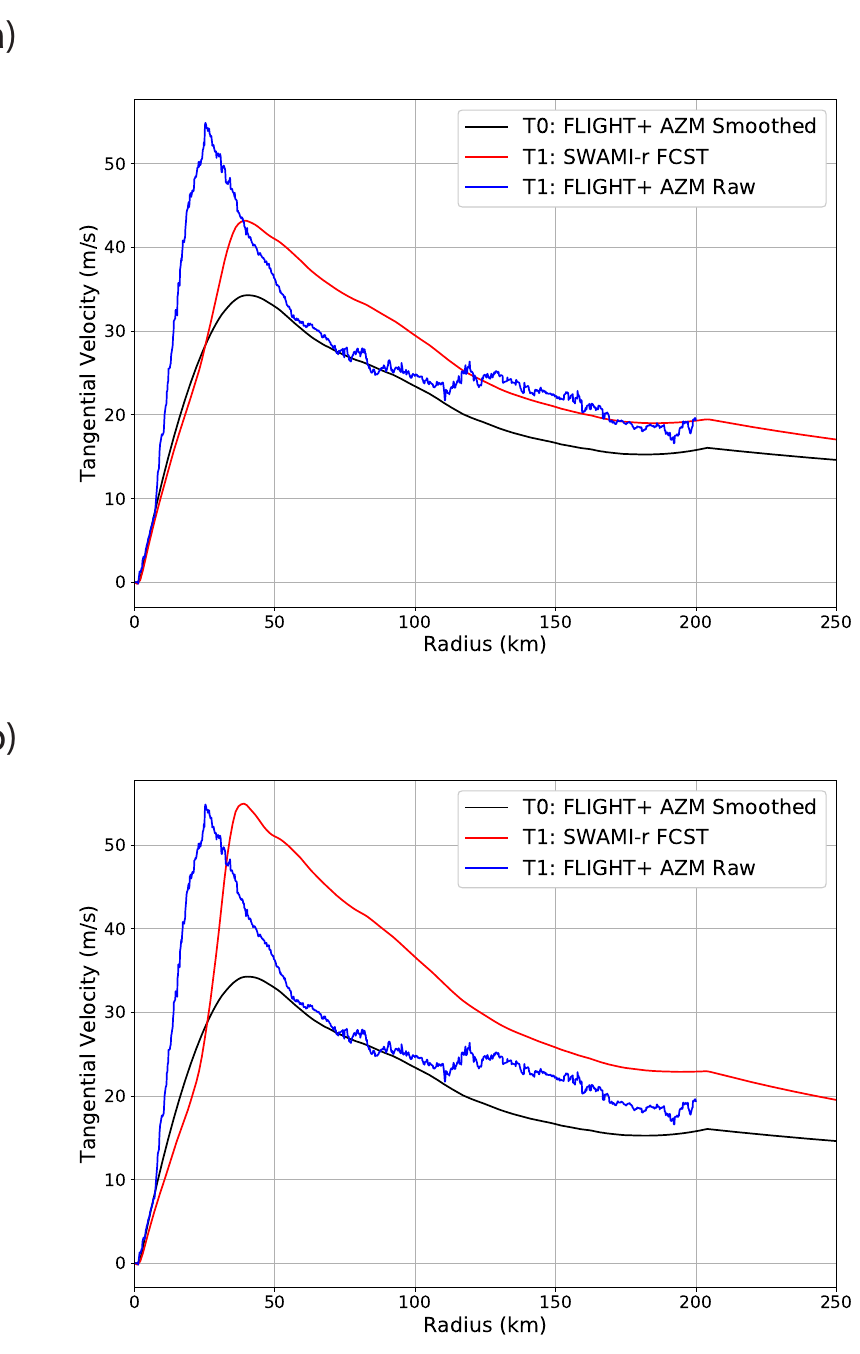
Figure 10. SWAMI forecasts of Hurricane Ignacio (2015) from 29 August 2015 03:58:24 to 29 August 2015 18:21:52 using the standard Q 0 [panel ( a )] and 2 Q 0 [panel ( b